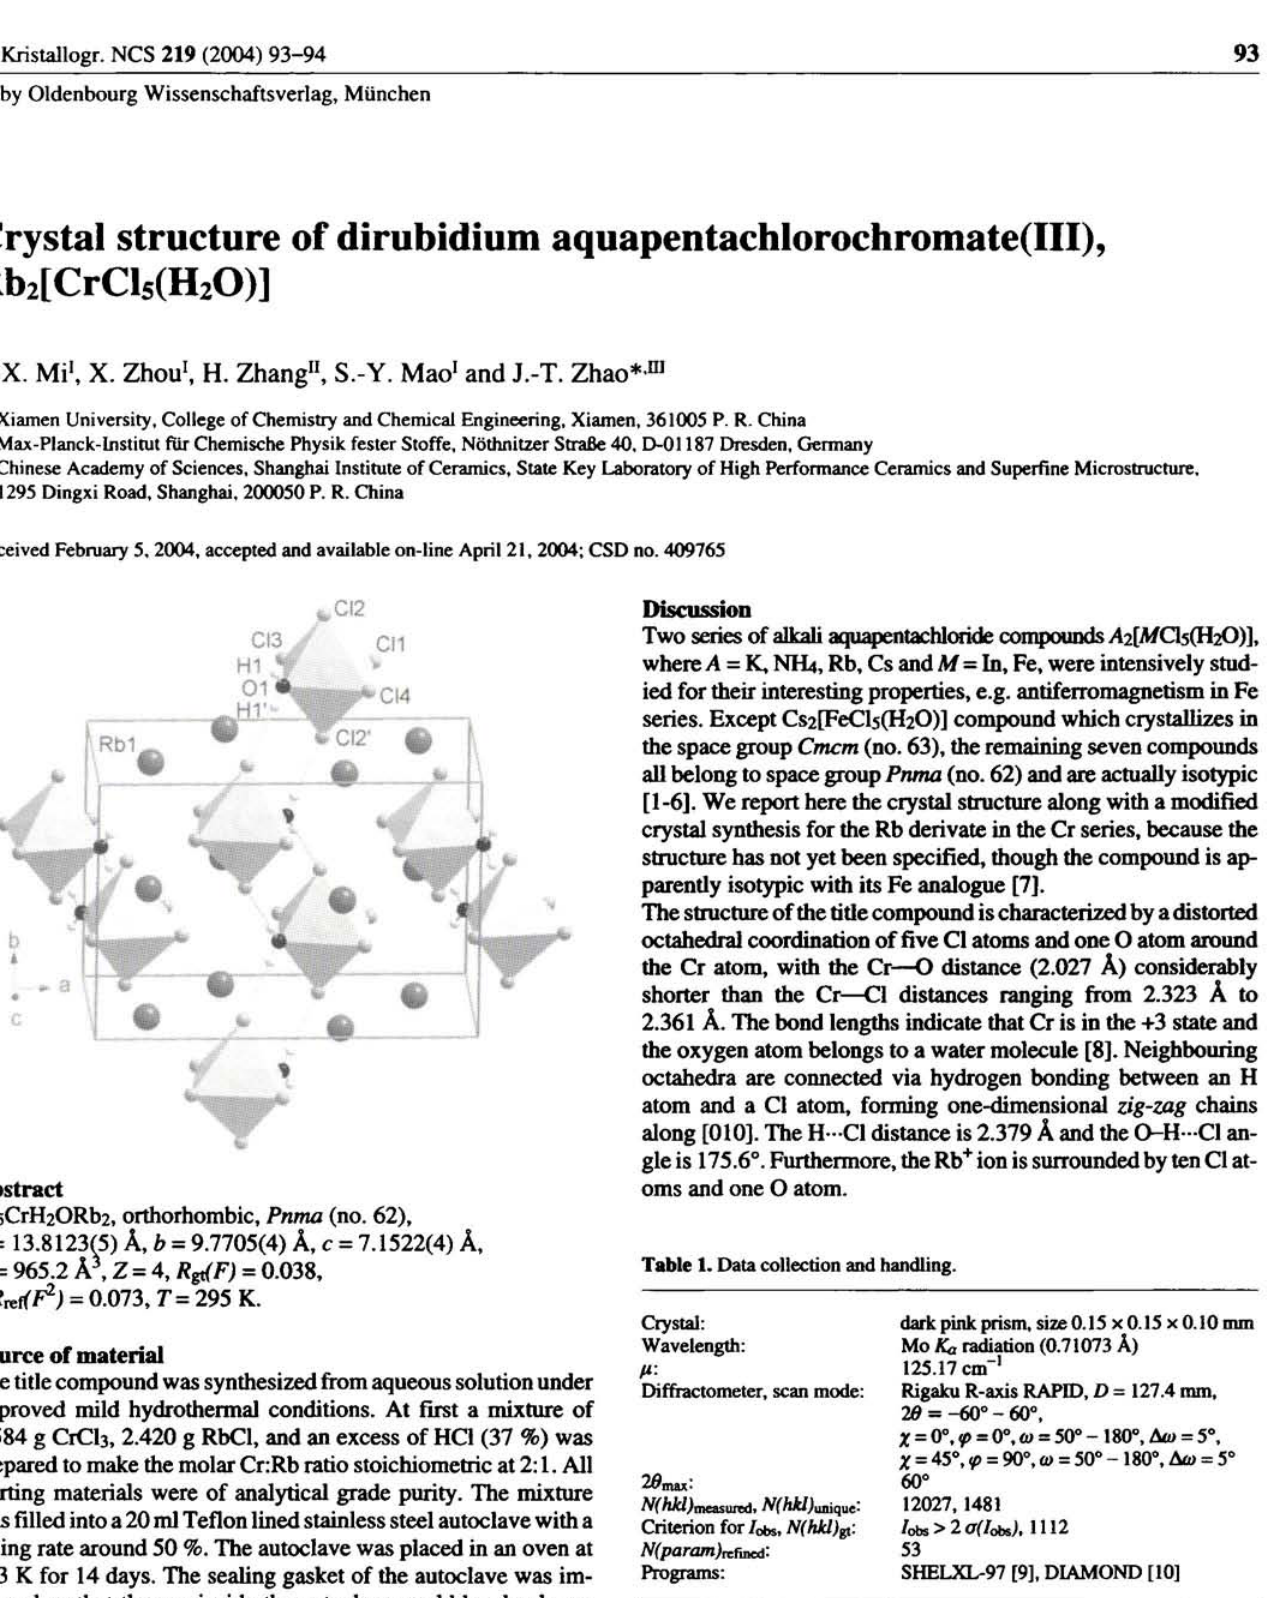
Table 2. Atomic coordinates and displacement parameters (in Â 2